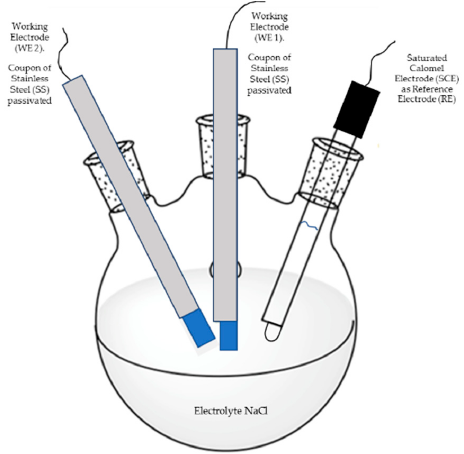
Figure 1. Experimental set up for electrochemical noise (EN) measurements.